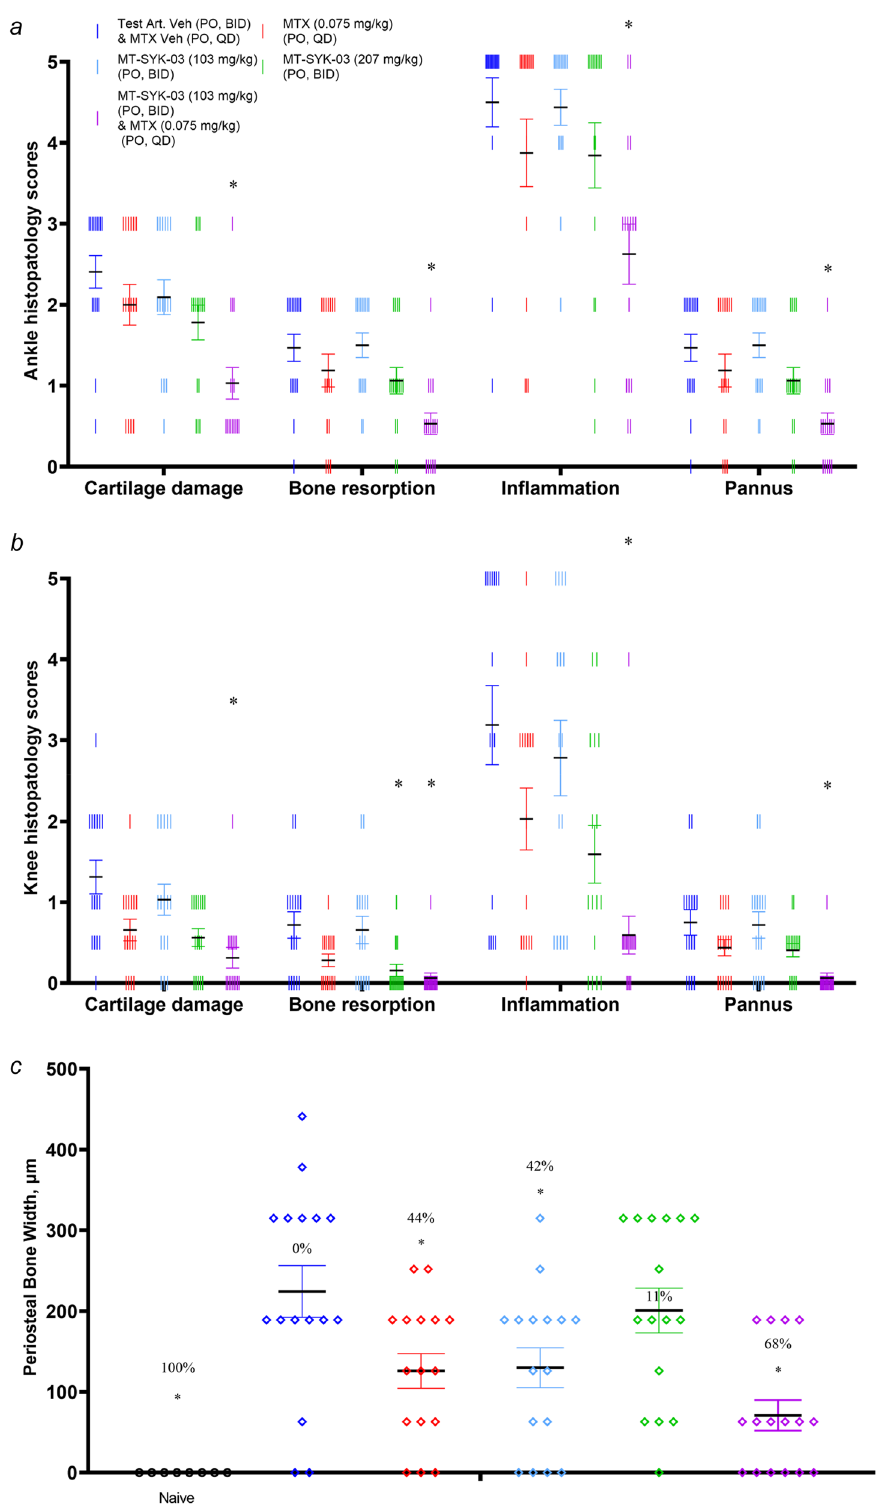
Figure 9. Effects of oral administration of MT-SYK-03 alone or in combination with MTX in 16 days rat semi- established CIA on inflammation, pannus, cartilage damage and bone resorption in ankles ( a ) and knees ( b ) and periosteal bone width in knee joints ( c ). Individual data, Mean ± SE (n = 8 for treatment groups and 4 for naive group, 2 paws were assayed for each animal). *p < 0.05 ANOVA to Vehicle